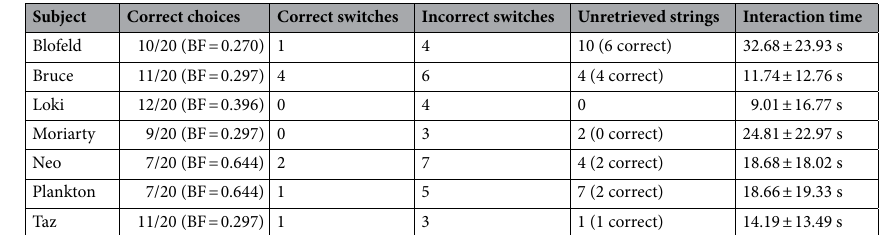
Table 1. Subjects’ performance in Experiment 1, with columns showing, in order: number of correct choices (measured as first touch) for the continuous string (Bayesian binomial test values in parentheses), number of times subjects first made a correct choice and then switched to the incorrect choice (counted as correct and ended the trial), number of times subjects made the incorrect choice and then switched to the correct choice (counted as incorrect and ended the trial), number of times subjects did not fully retrieve the chosen string from the apparatus and how many of these unretrieved strings were the correct choice, and average time spent interacting with